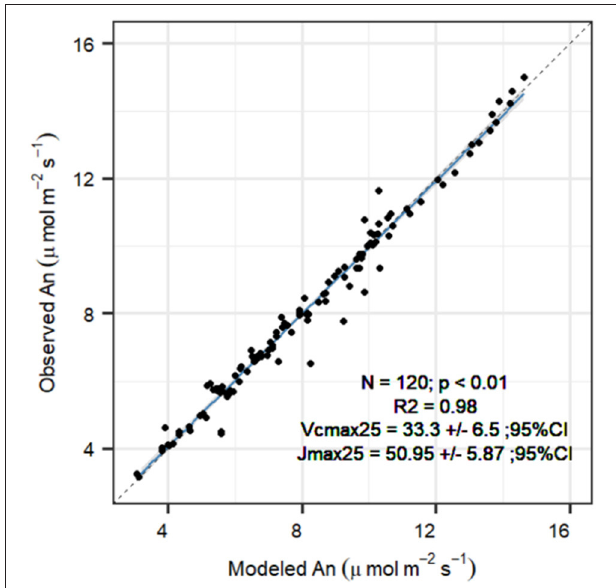
FIGURE 3 | Comparison between FvCB model net assimilation (An, µ mol m − 2 s − 1 ) projections with observations after parameter optimization for each A n / C i curve ( n = 19), for the P. sylvestris saplings grown in the greenhouse in year 2019. Reported are the fit ( R 2 ), the median optimum V cmax ,25 ± 95% confidence interval, and the median optimum J max ,25 ± 95% confidence interval. The solid line indicates the trend between observed and modeled An ( p < 0.01), with the gray area representing the 95% CI. The slope was not significantly different than 1 ( p > 0.1), and intercept was not significantly different than 0 ( p > 0.1) based on a t -test. Dashed line represents the 1:1